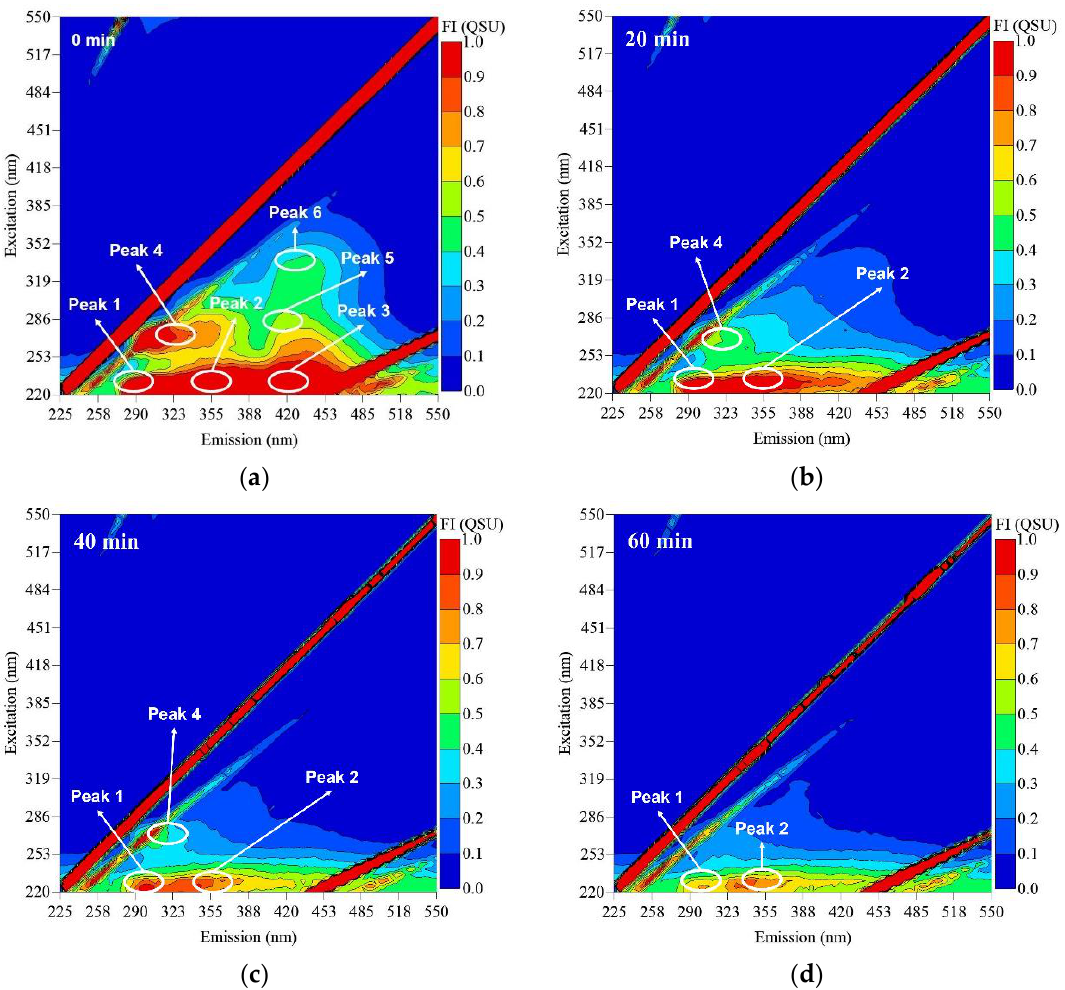
Figure 4. Fluorescence spectra of rainwater before and after RF treatment. ( a ) 0 min, ( b ) 20 min, ( c ) 40 min, and ( d ) 60 min. Peak 1: protein-like tyrosine; Peaks 2 and 4: protein-like tryptophan; Peak 3: fulvic acid-like; Peak 5: marine humic-like; and Peak 6: humic-like from fluorescence EEM.